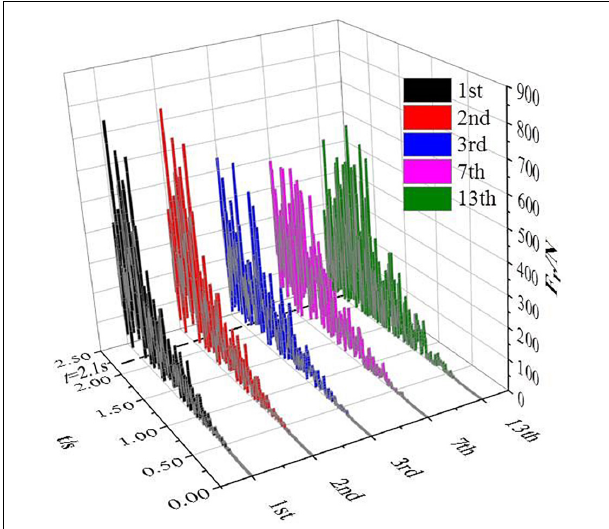
FIGURE 6 | Radial force change diagram of impellers with different series during the closed-valve start-up.